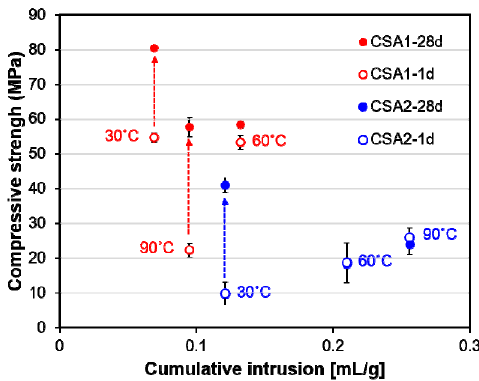
Figure 12. Relationship between compressive strength measured at 1 day and 28 days and cumulative intrusion data measured at 28 days. Grey arrows indicate the gain of strength from 1 day to 28 days for selected samples. Note that two points of strength of CSA2-60 at 1 and 28 days are overlapped.